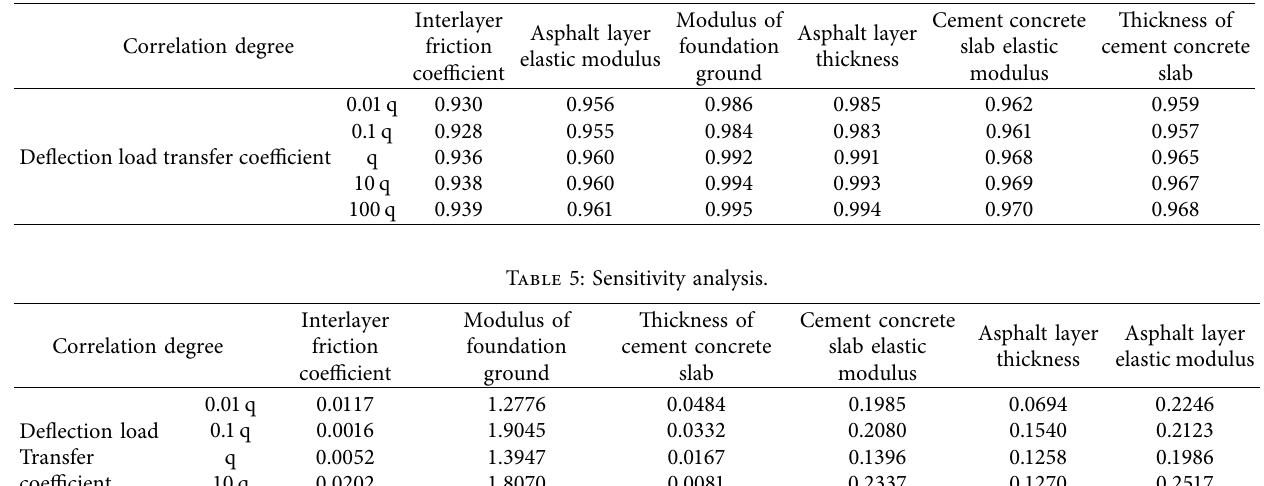
Table 4: Correlation between reference sequence and contrast sequence.